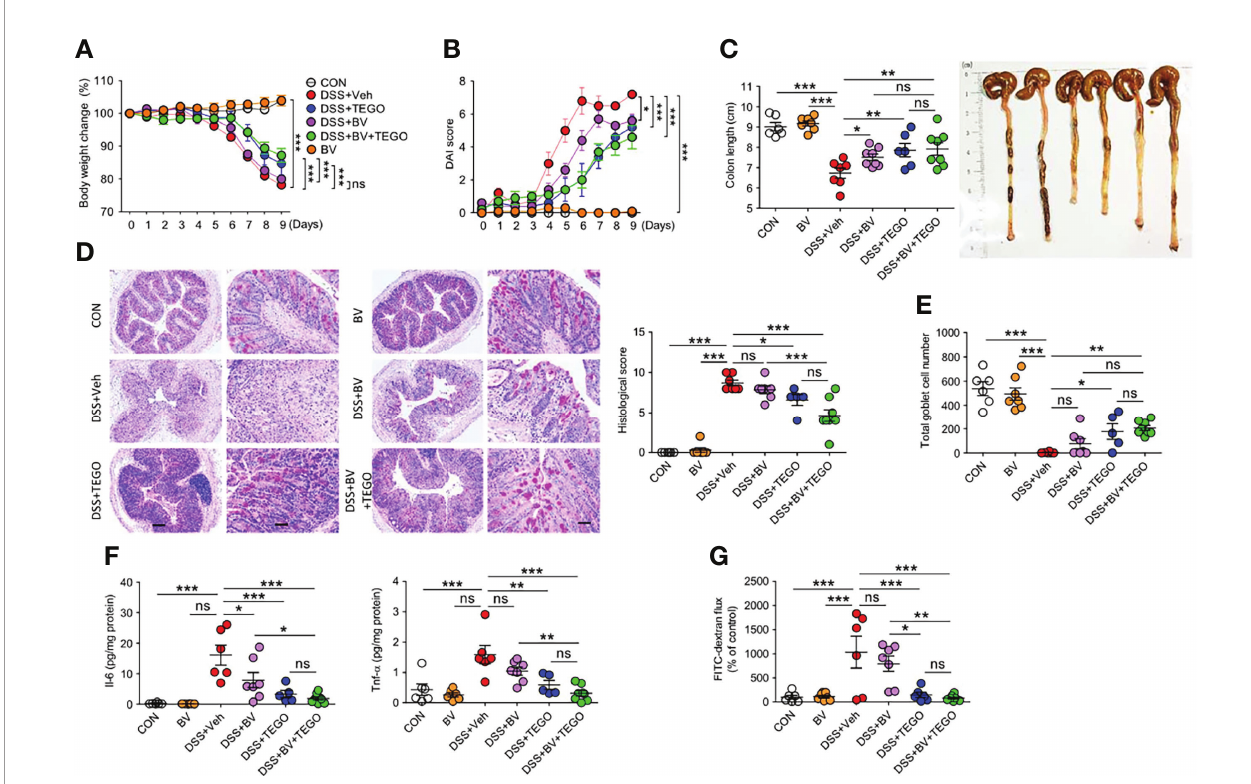
FIGURE 5 | Bacteroides vulgatus alleviates aspects of DSS-induced colitis. Colitis was induced in 8-week-old male mice by administering 2% DSS in distilled drinking water for 5 days, followed by normal drinking water for 4 days. B vulgatus (5 × 10 8 CFU/mouse/day) was administered daily and tegoprazan (30 mg/kg) and rabeprazole (30 mg/kg) were administered orally, twice daily throughout the experimental period: CON and DSS+Veh (each n = 6), DSS+TEGO (n = 5), DSS+BV and BV (n = 7), and DSS+BV+TEGO (n = 8). After sacri fi cing animals on Day 9, the entire colon from anesthetized mice was harvested for further investigations. The detailed methods are described in the Materials and Methods section. (A) Body weight change. (B) Disease activity index. (C) Representative images of colons and colon length. (D, E) Representative images following periodic acid-Schiff (PAS)-staining and histological score (D) and goblet cell number (E) . Scale bars = 20 m m. (F) Plasma level of Il-6 and Tnf- a . Plasma cytokine concentrations were measured using cytometric bead array analysis. (G) FITC-dextran fl ux (arbitrary unit) was plotted as a percentage of the control. Data represent the mean ± standard error of the mean (S.E.M). Signi fi cance is indicated by * p < 0.05, ** p < 0.01, and *** p < 0.001 using two-way ANOVA followed by Bonferroni post hoc test (A, B) and one-way ANOVA followed by Dunnett ’ s multiple comparison test (C – F) . ns, not signi fi cant; CON, normal control; BV, treated with B vulgatus ; DSS, treated with dextran sulfate sodium; Veh, treated with vehicle; TEGO, treated with tegoprazan; Il-6, interleukin-6; Tnf- a , tumor necrosis